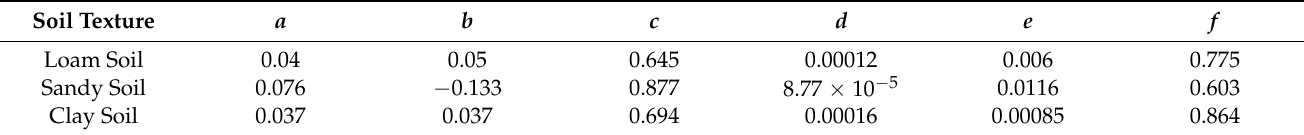
Table 6. Constant values of correction equation for measuring soil moisture sensors by soil